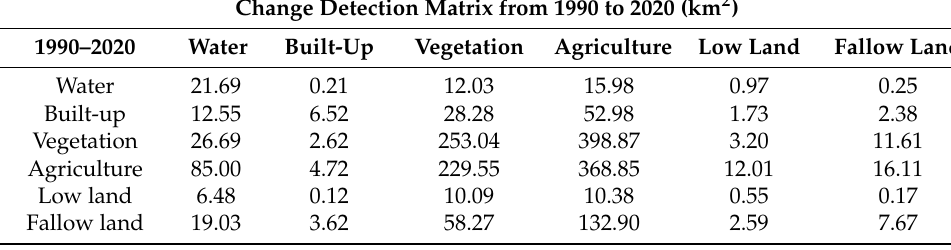
Figure 6. Land-use/land-cover conversion (1990–2020).1 = W to W, 2 = W to B, 3 = W to V, 4 = W to A, 5 = W to L, 6 = W to F, 7 = B to W, 8 = B to B, 9 = B to V, 10 = B to A, 11 = B to L, 12 = B to F, 13 = V to W, 14 = V to B, 15 = V to V, 16 = V to A, 17 = V to L, 18 = V to F, 19 = A to W, 20 = A to B, 21 = A to V, 22 = A to A, 23 = A to L,24 = A to F, 25 = L to W, 26 = L to B, 27 = L to V, 28 = L to A, 29 = L to L, 30 = L to F, 31 = F to W, 32 = F to B, 33 = F to V, 34 = F to A, 35 = F to L, 36 = F to F. W = Water, B = Built-up, V = Vegetation, A = Agriculture, L = Low land, F = Fallow land. Table 6. Changes in land use/land cover